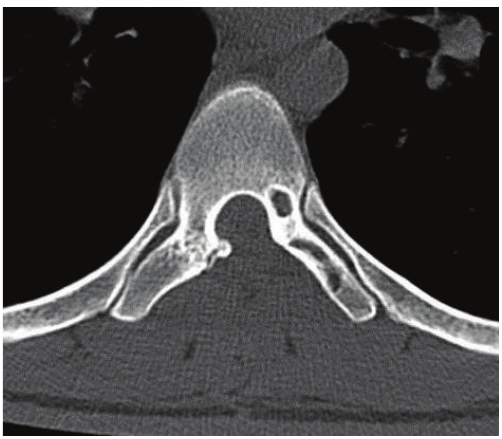
Figure 7: Postoperative 2-year follow-up axial CT scan: the eroded bone areas are in a healing